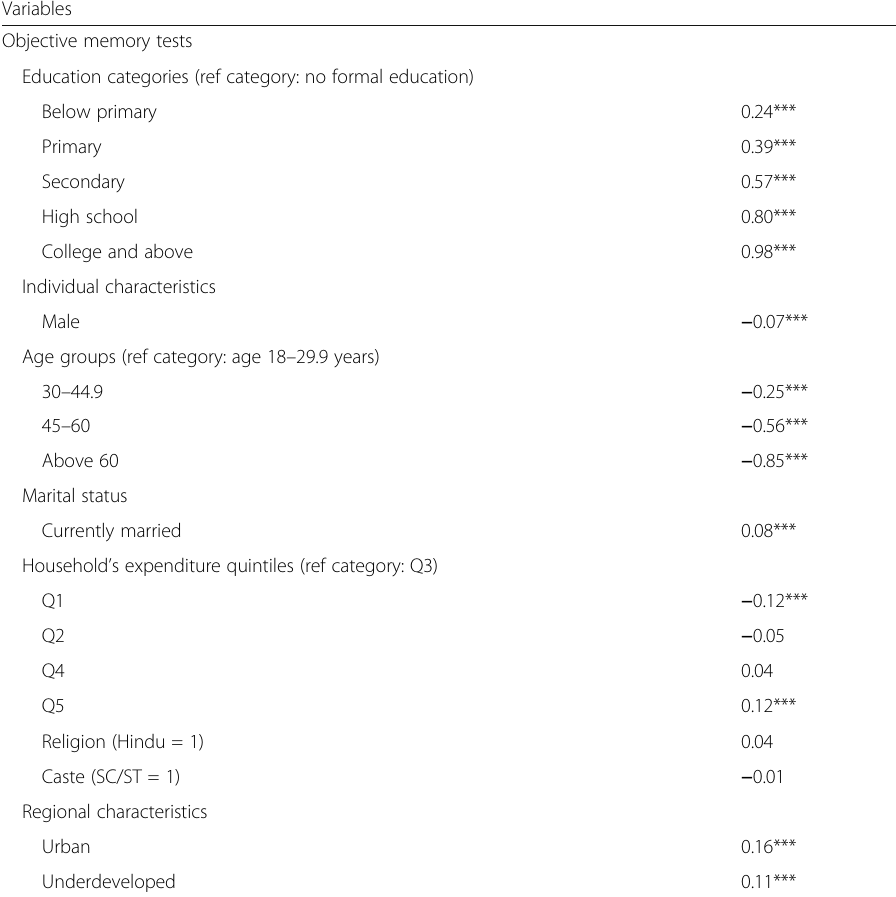
Table 10 Dependent variable: objective memory tests Variables Objective memory